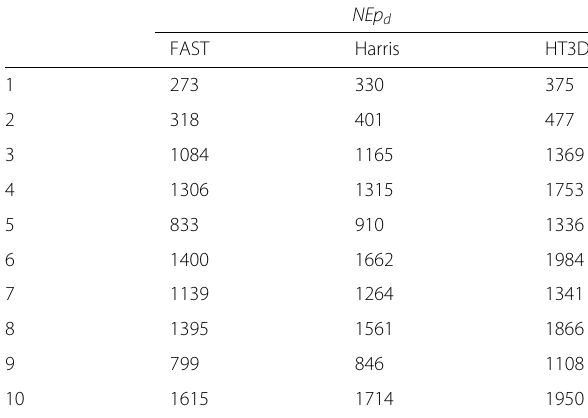
Table 1 Number of detected corners/endpoints ( NEp d ) for the ten test images